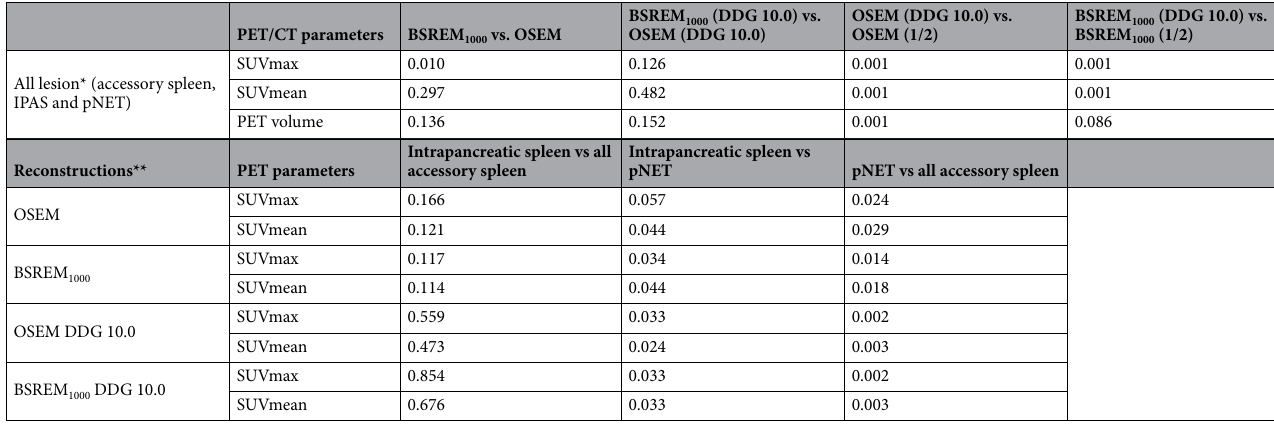
Table 2. P -values of Mann–Whitney U-test of PET/CT parameters comparing the three samples (all accessory spleens, IPAS and pNETs) in each reconstruction in the subcohort of exams acquired retrospectively (42 accessory spleens, 6 IPAS and 8 pNET), as well as P -values of Wilcoxon signed-ranks test of PET/CT parameters of all lesions (42 accessory spleens, 6 IPAS and 8 pNET) among different reconstructions in the subcohort of exams acquired retrospectively. All lesion*: p-value was calculated with Wilcoxon signed-ranks test. Reconstructions**: p-value was calculated with Mann–Whitney U-test.